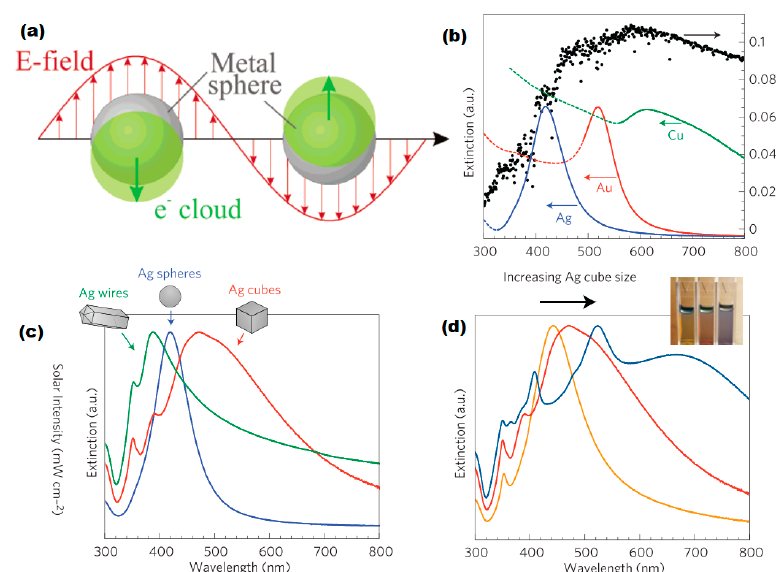
Figure 1. ( a ) Schematic illustration of plasmonic resonant of the free electron cloud around spherical metal particles. Reproduced with permission from [14]. Copyright American Chemical Society, 2003. ( b ) Normalized extinction spectra of Ag, Au and Cu particles, ( c ) Normalized extinction spectra of Ag cube, sphere and wire, ( d ) Size-dependent extinction spectra of Ag nanocubes. Reproduced with permission from [15]. Copyright Springer Nature,